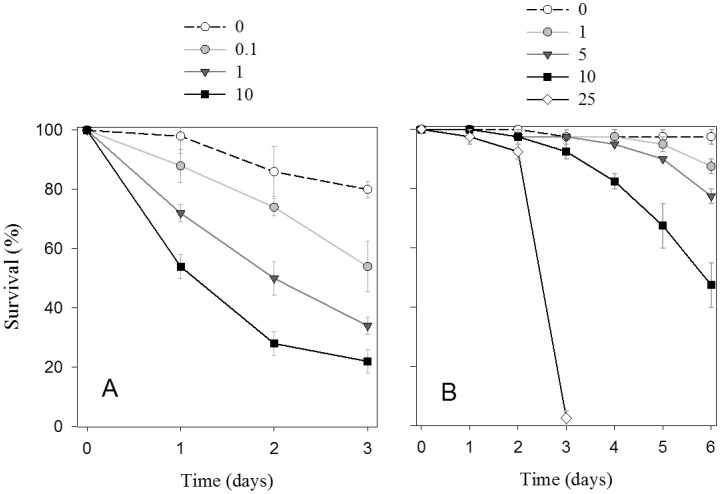
Temporal variation of the survival (%) of ephyra larvae of the scyphozoan Aurelia aurita (A) and cydippid larvae of the ctenophore Mnemiopsis leidyi (B) exposed to different concentrations of crude oil (µL L−1).Symbols show the average values of mortality and error bars represent the standard errors.